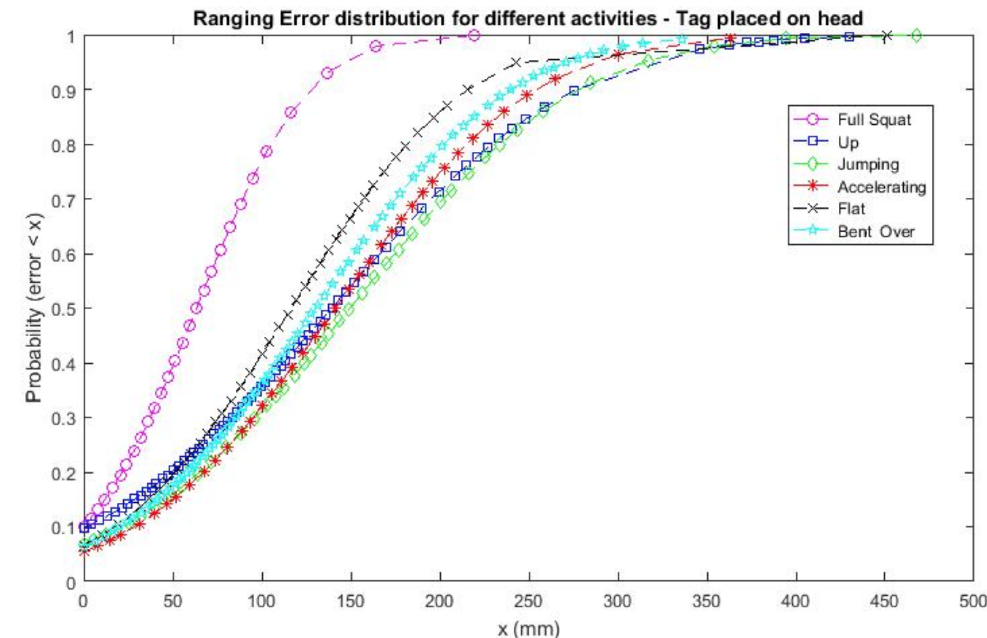
Figure 8. Ranging error distribution for different postures and activities while estimating the distance to eight anchors—head